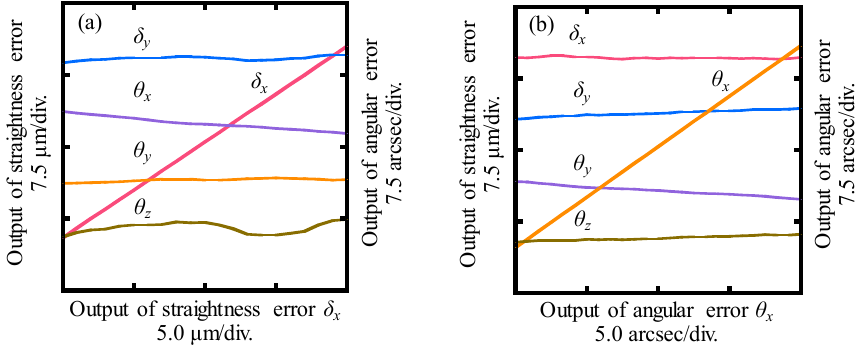
Figure 10. Crosstalk errors of the LMS when the sensor head was: ( a ) Moved along X -direction in the range of ±10 μ m, ( b ) rotated about X -direction in the range of ±10 arcsec.